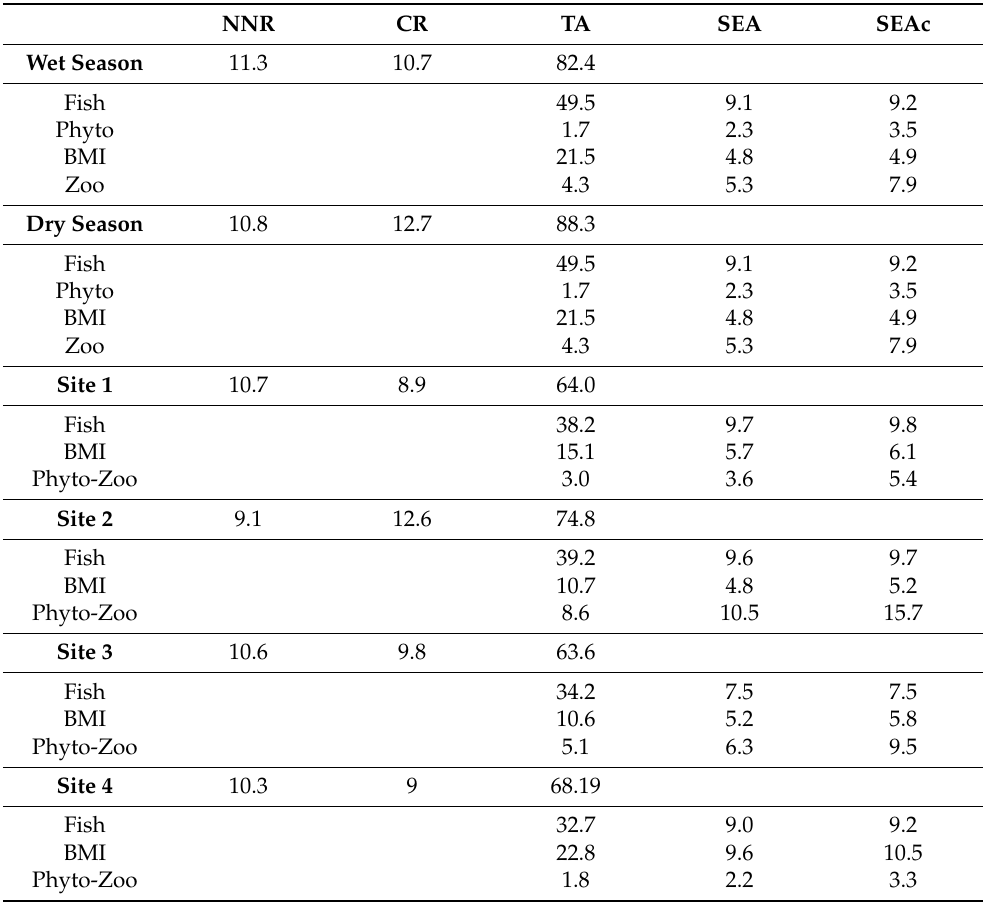
Table 5. Metrics of the niche breadth and isotopic overlap between the species per site and season. Abbreviations: CR = range in δ 13 C, NNR = range in δ 15 N, TA = total area, SEA = Bayesian standard ellipse area, SEAc = Bayesian standard ellipse area